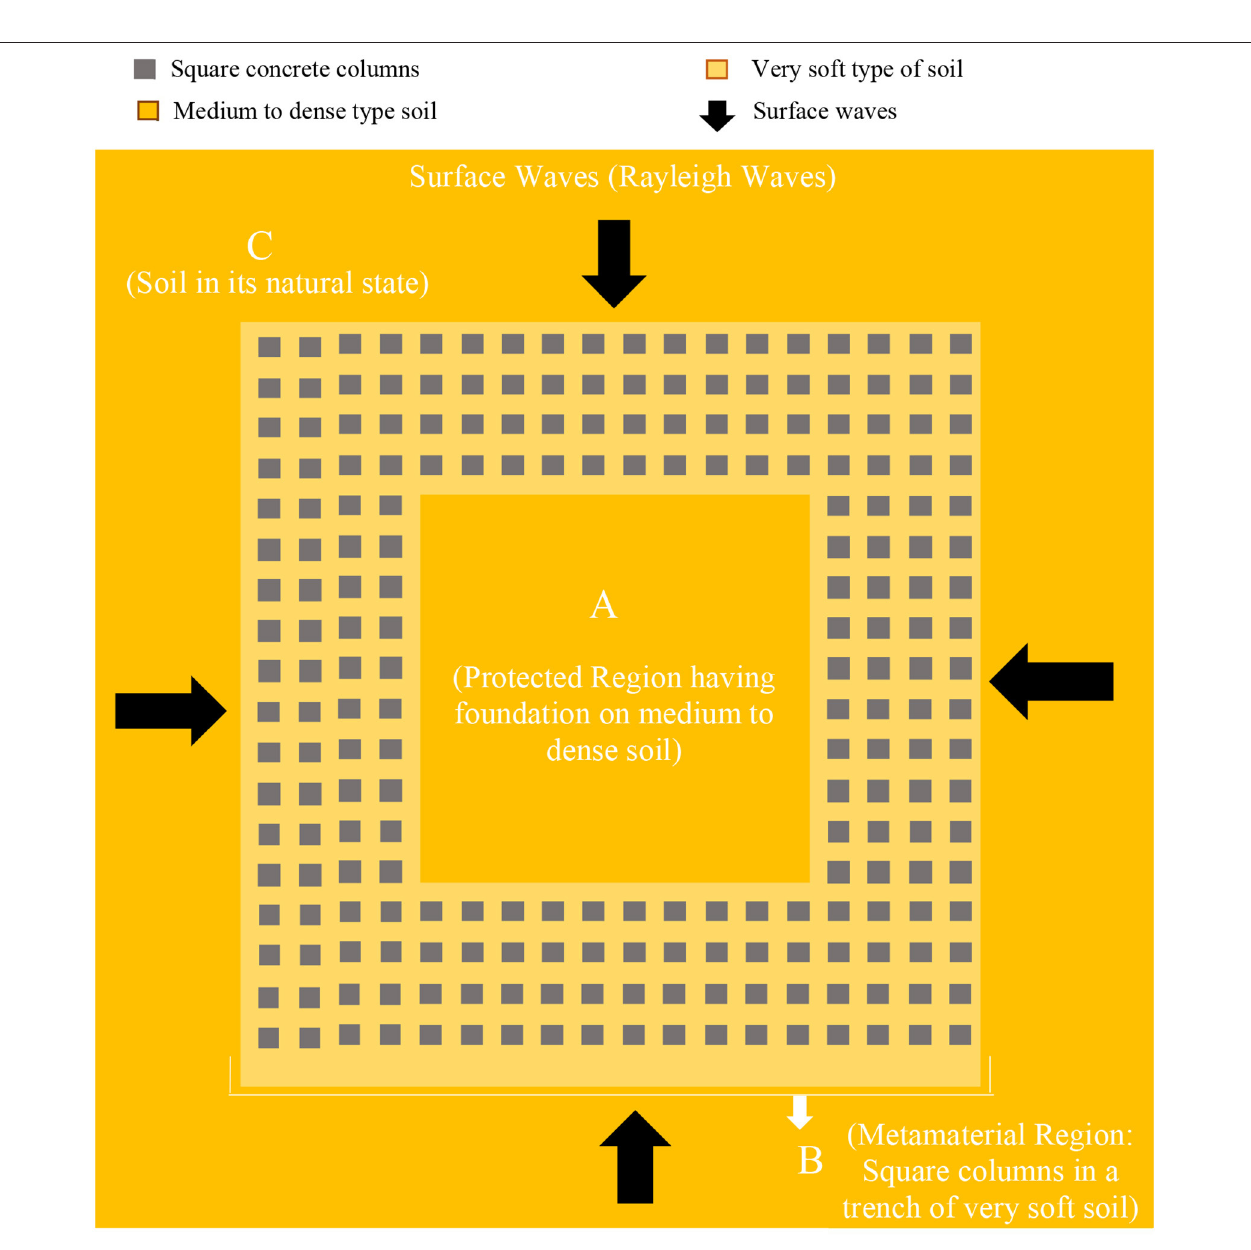
FIGURE 12 | Schematic representation of the proposed design for metamaterial. Square columns of M50 grade embedded in loose soil matrix with properties, E = 10 MPa, µ = 0.25, and ρ = 1,400 kg / m 3 are placed along a trench surrounding the protected area. The square concrete columns have substitution ratio 0.445 in the unit cell and are not clamped to the